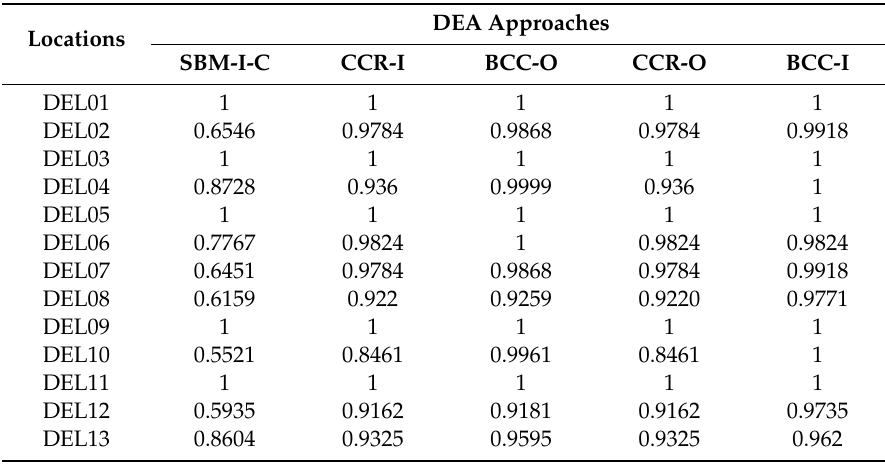
Table 6. Ranking results from some DEA